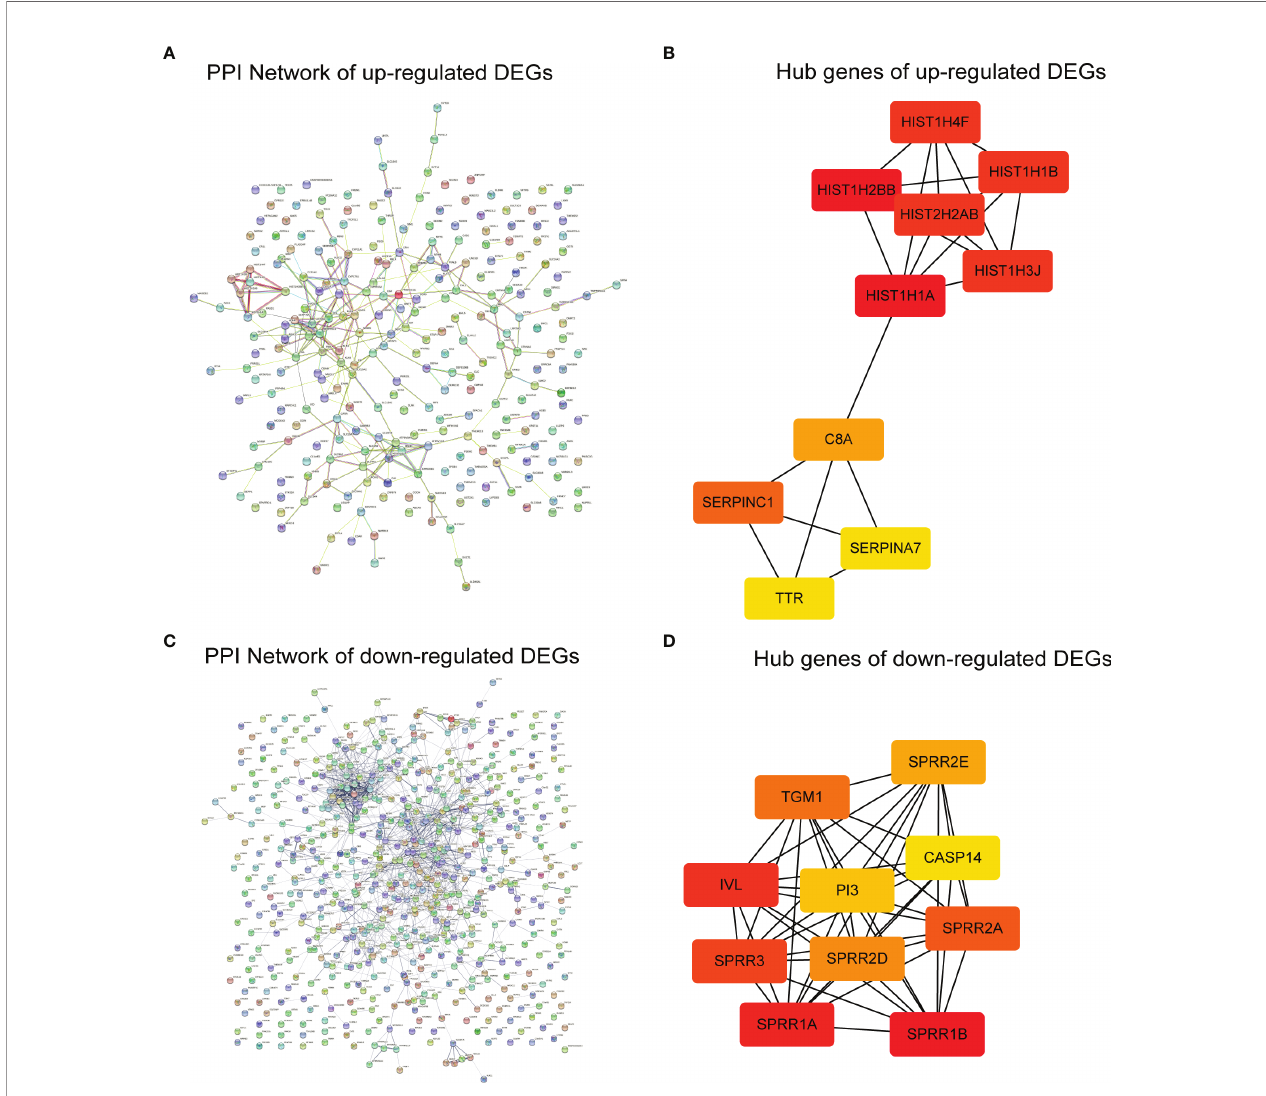
FIGURE 8 | Identi fi cation of hub genes. (A) The protein – protein interaction (PPI) network was constructed with upregulated differentially expressed genes (DEGs). (B) The hub genes identi fi ed with Cytoscape for upregulated DEGs. (C) The PPI network was constructed with downregulated DEGs. (D) The hub genes identi fi ed with Cytoscape for downregulated